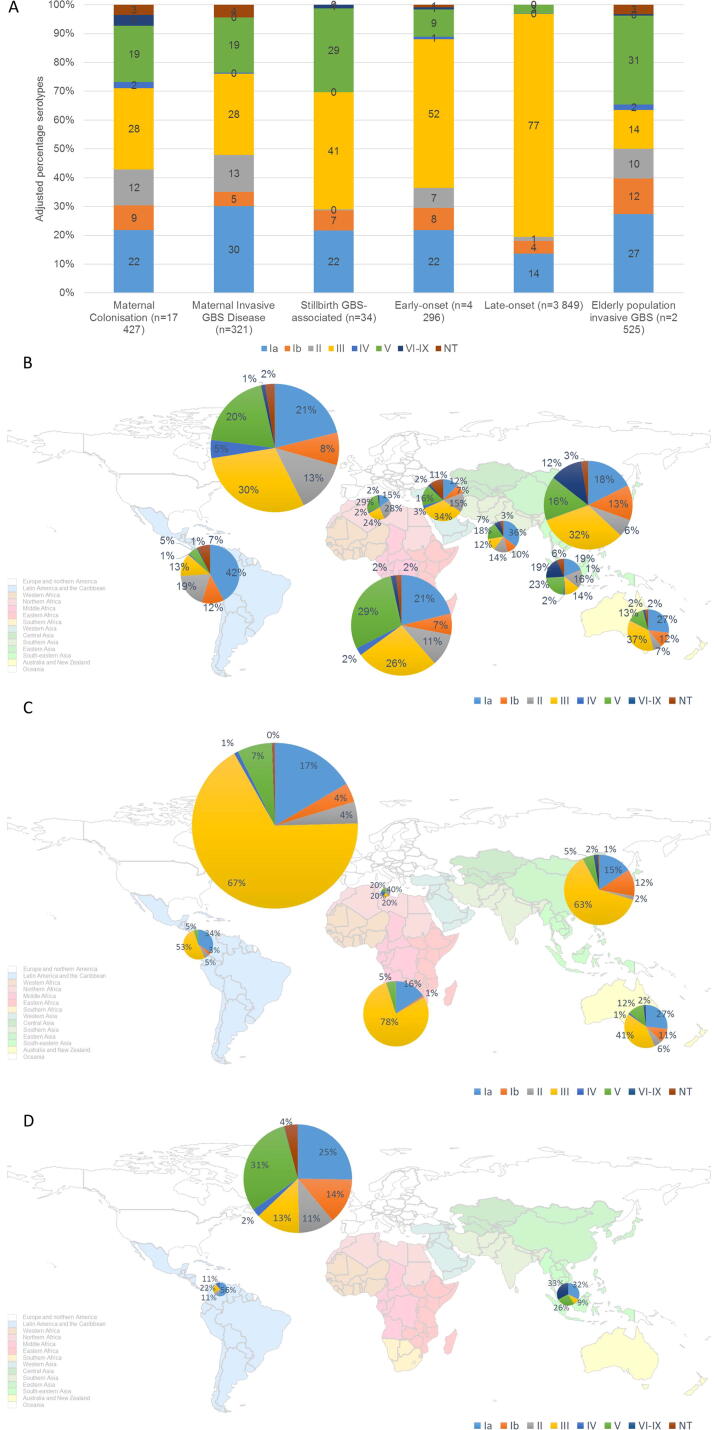
A. Distribution worldwide of GBS serotypes by risk population group, B. distribution of GBS serotypes by regions from maternal colonisation isolates (n = 17427), C. distribution of GBS serotypes by regions from infant invasive disease and stillbirth isolates (n = 8974), D. distribution of GBS serotypes by regions from invasive disease in elderly population isolates (n = 2525). Results are of adjusted percentages. Size of pie charts correspond to number of isolates from each region. Scale of pie charts not the same between figures B, C and D.